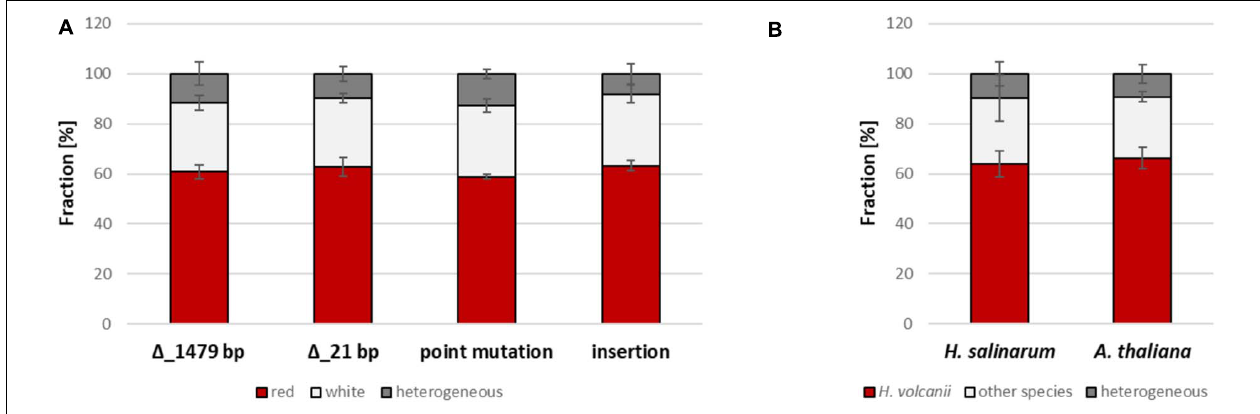
FIGURE 7 | Results of gene conversion experiments between the wildtype genome and genomes with various modifications at one site. (A) Results of the gene conversion experiments that are schematically shown in Figure 6 are summarized. Between 2,617 and 6,324 colonies were analyzed ( Supplementary Table 5 ), and the fractions of white colonies, red colonies, and heterogenous colonies were quantified. The average fractions (%) of four biological replicates and their standard deviations are shown. A statistical analysis of significance was performed (one-way ANOVA) and the differences between the fractions of red and white clones were not significant ( P > 0.05). (B) The results of two experiments are shown in which instead of mutated version of HVO_2528 orthologous genes from other species were used, as indicated. For the H. salinarum ortholog, the 222 resulting clones were analyzed by PCR, for the A. thaliana ortholog, the colors of 5,491 colonies were analyzed. The average fractions (%) of, respectively, three biological replicates ( H. salinarum ) and four biological replicates ( A. thaliana ) and their standard deviations are shown. A statistical analysis of significance was performed (unpaired t -test) and the differences were not significant in both cases ( P >